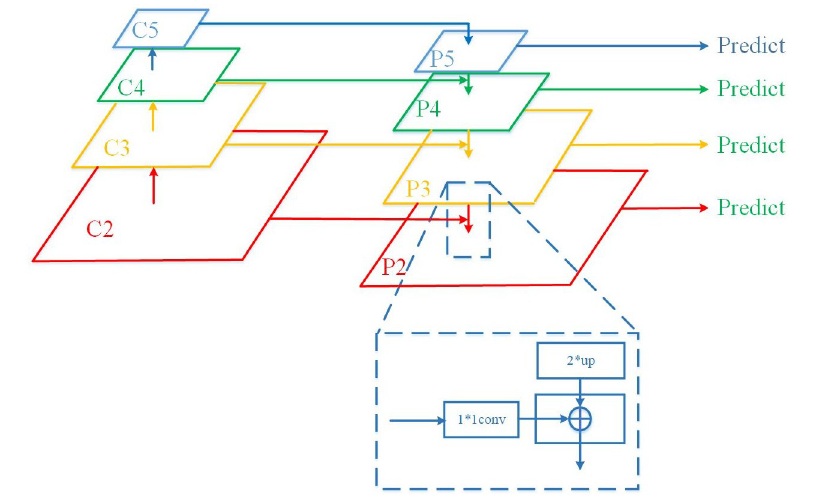
Fig 3. MobileNetV2 FPN